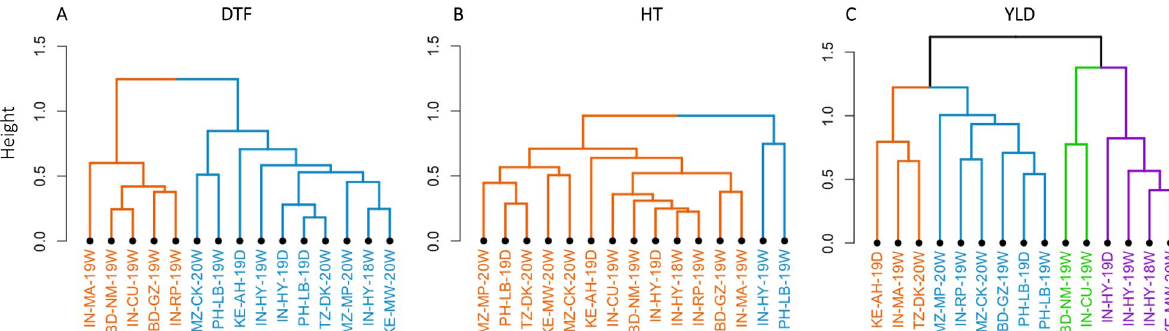
Fig. 3 Hierarchical clustering of environments for the three traits. DTF days to flowering (panel A ); HT plant height (panel B ); YLD grain yield (panel C ). The different colors present different clusters among environments. The names of environments in the clusters are formatted by ordering country name, location, year, and season (see Table